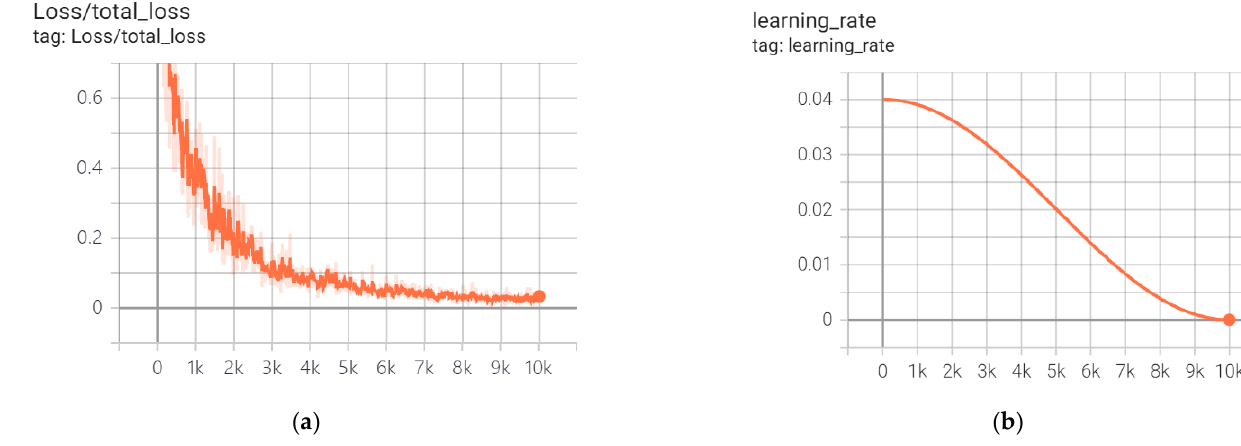
Figure 4. ( a ) Validation total loss graph and ( b ) the learning rate schedule.